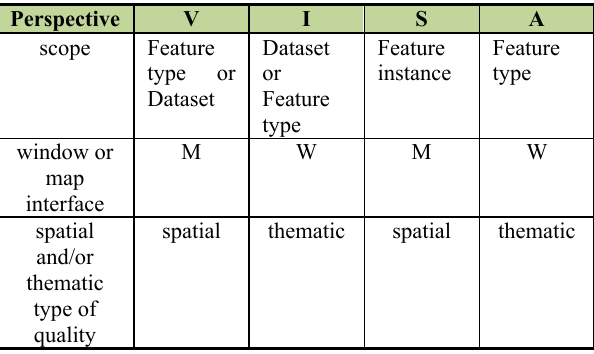
Table 1. Comparison table of each visual aid in VISA